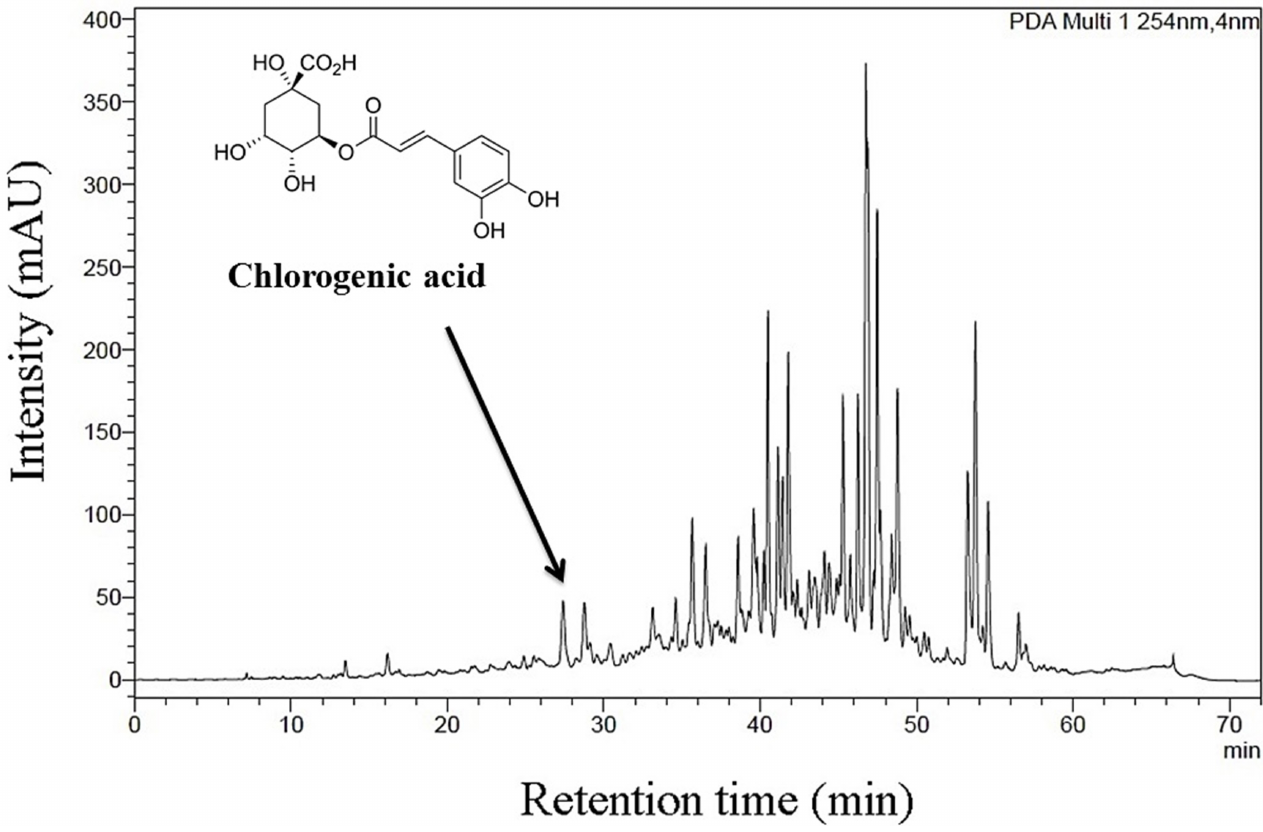
FIGURE 4 - Chromatographic profile of the chloroformic phase of the underground parts of Cyperus articulatus L. (CFCAUP) at 254 nm